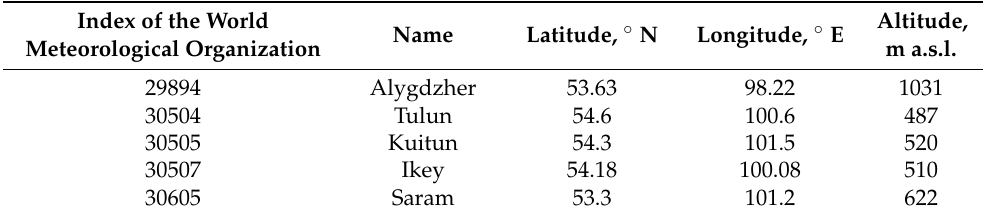
Table 1. Information about meteorological stations, daily data of which are used as boundary conditions in the runoff generation model over the period 1970–2019.